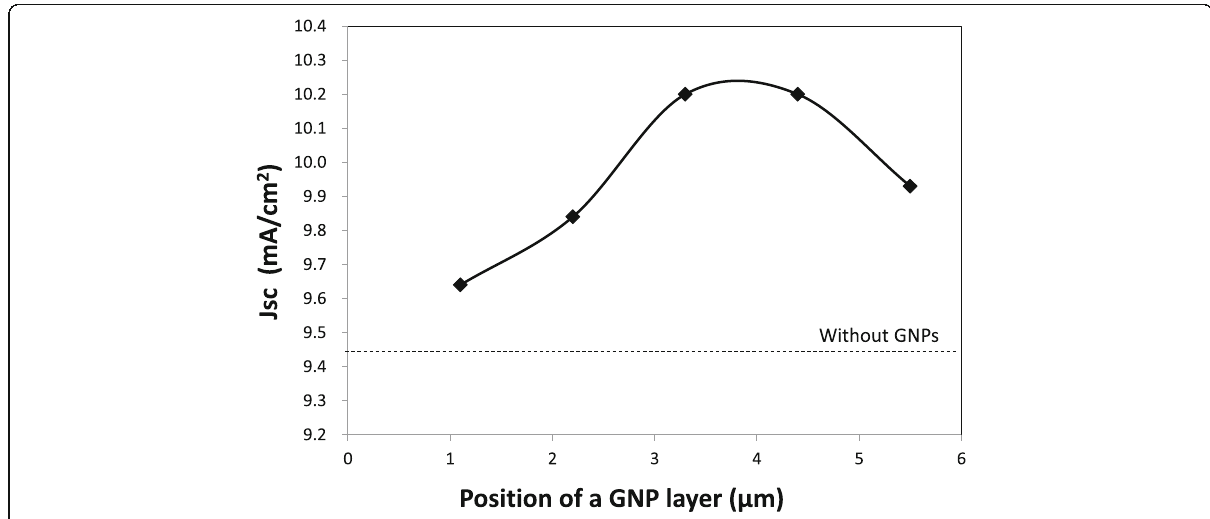
Fig. 10 Dependence of J sc on the position of a GNP layer. The density of GNPs is 2.7 μ g/cm